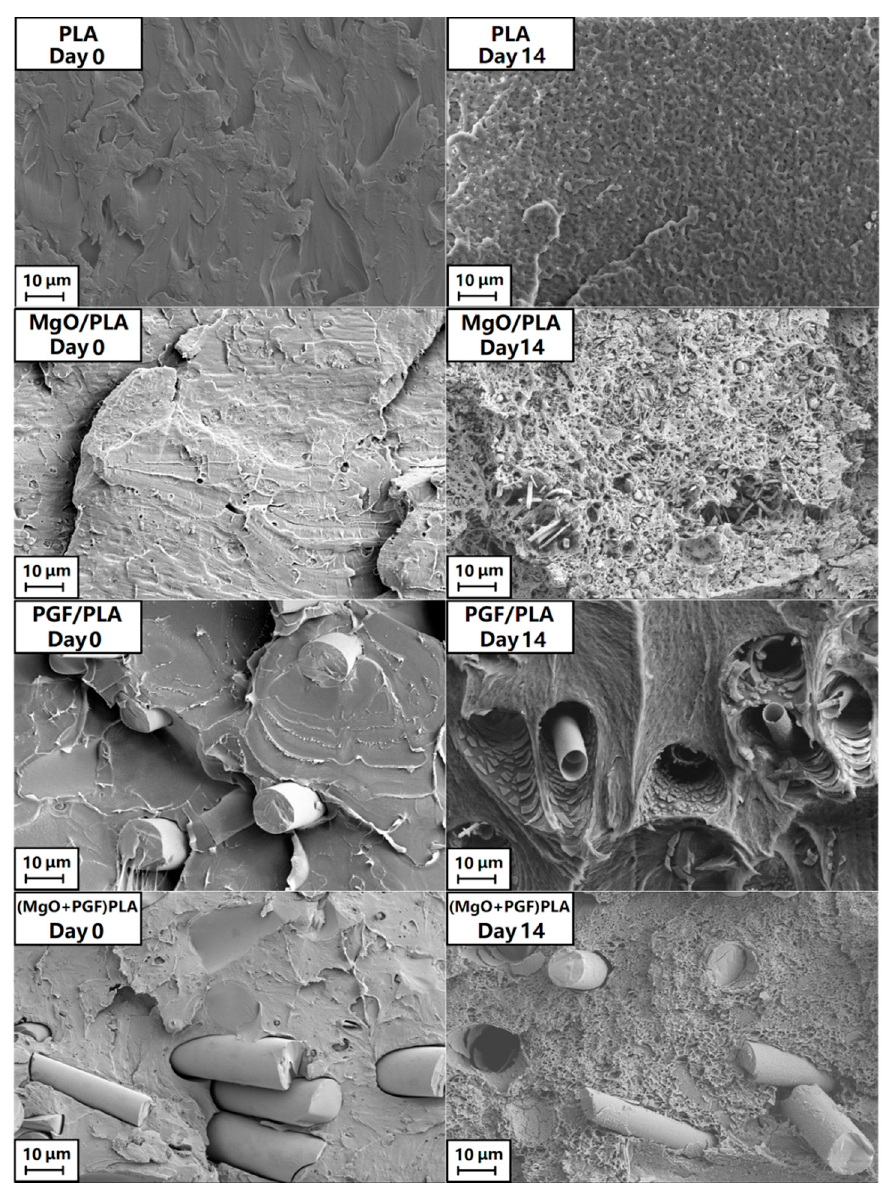
Figure 6. The freeze-fractured surfaces of different scaffolds before and after 14 days of in vitro degradation in Tris-HCl under 37 °C.